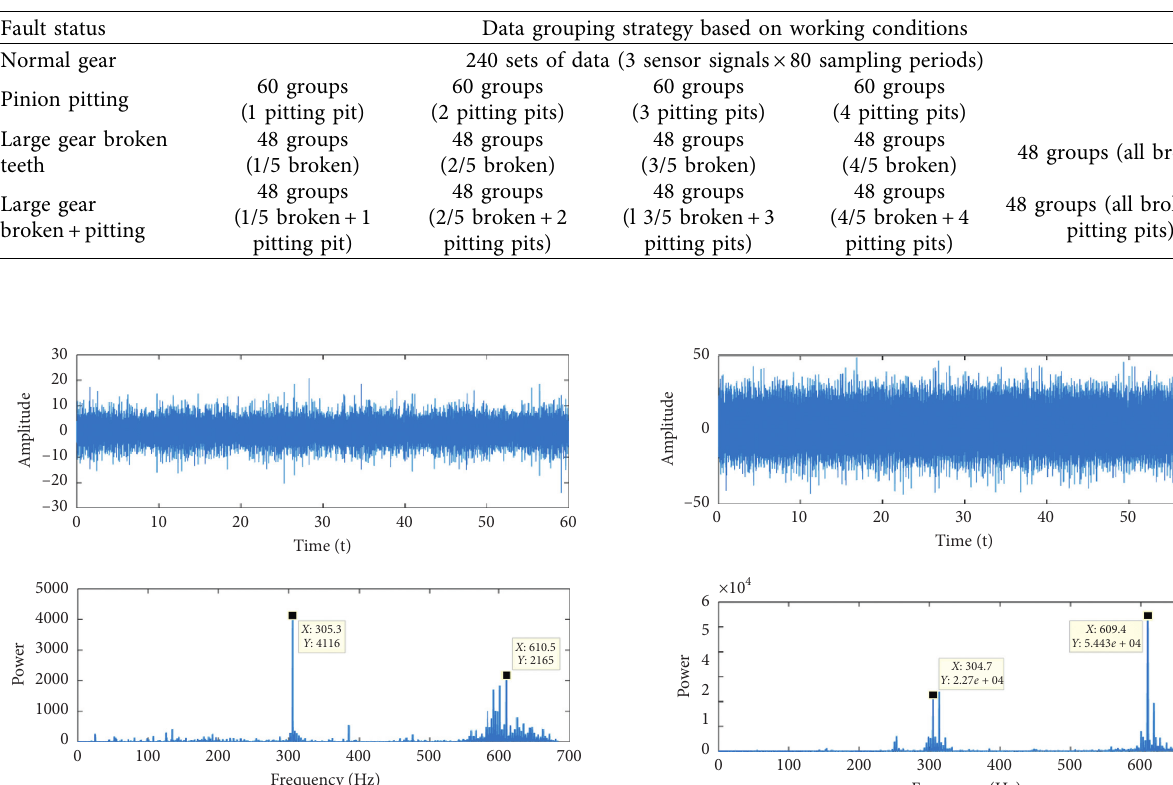
Table 2: Data sampling strategy for different fault levels on four states.